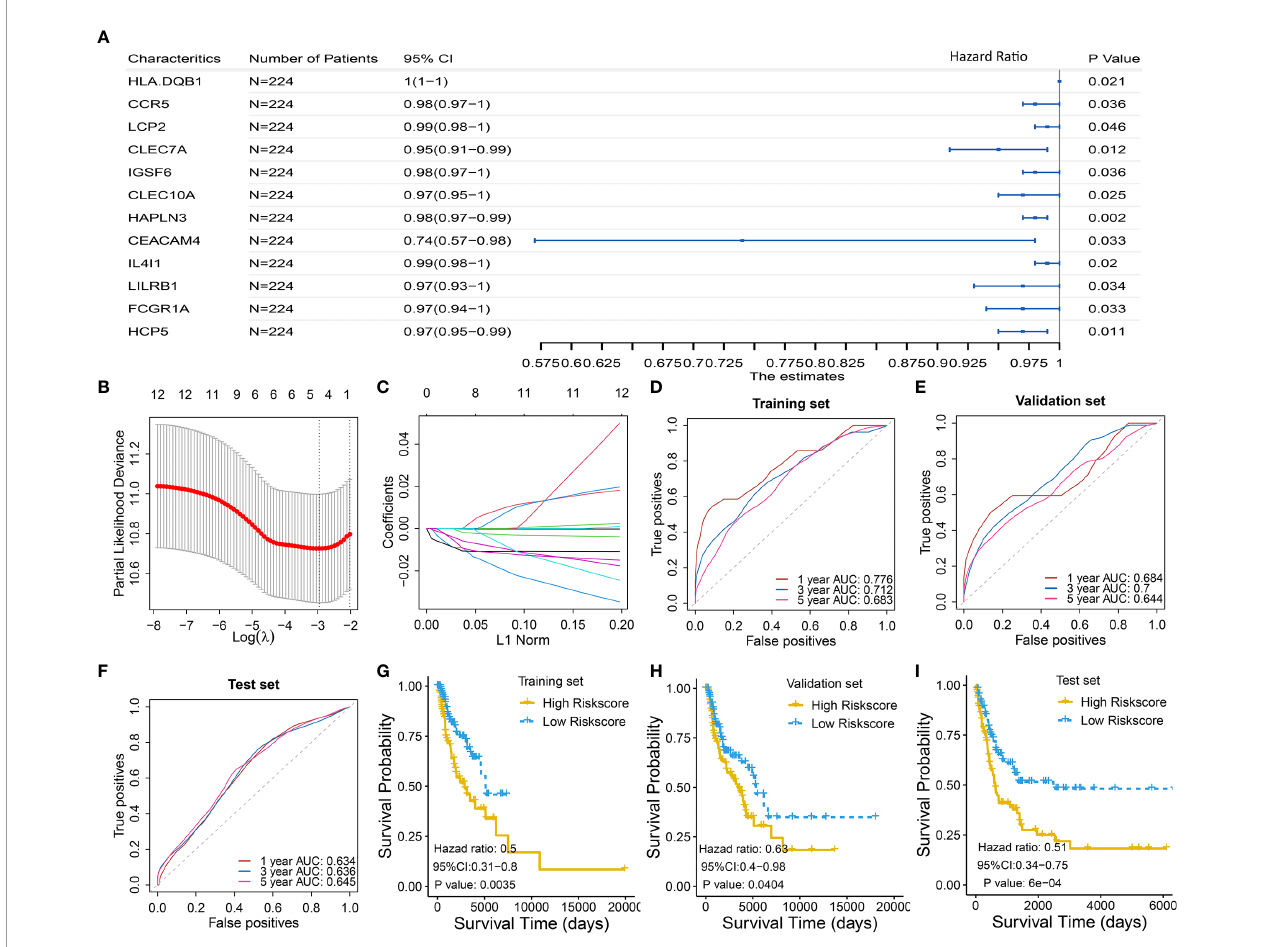
FIGURE 3 | Identi fi cation and validation of four-gene biomarker (A) Univariate Cox regression were used to screen for genes that were signi fi cantly correlated with overall survival in the training set I (n = 224). Twelve genes with P value less than 0.05 were signi fi cantly associated with overall survival, as shown in the forest plot. (B – C) LASSO regression was used to further eliminate redundant genes. The resulting four genes of CLEC7A , CLEC10A , HAPLN3 , and HCP5 were used to develop a four-gene biomarker based on multivariate Cox regression model. (B) Tuning parameter ( l ) selection in the LASSO model used 10-fold cross-validation via minimum criteria. AUC was plotted versus log( l ). (C) Coef fi cient pro fi les of the fractions of 12 immune-related genes. (D – F) One-, 3-, and 5-year AUC were calculated for the prognostic four-gene biomarker, showing good predictive performance in the training set I, validation set I, and test set. (G – I) Risk scores of melanoma cases were calculated according to multivariate Cox regression model of the four genes, and grouped into low-risk and high-risk group using median risk score as threshold. Low-risk group has a signi fi cant longer survival compared to high-risk group, in the training set I, validation set I, and test